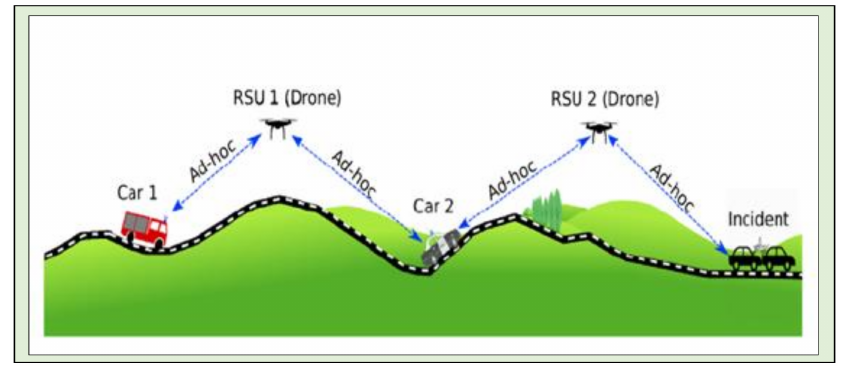
Figure 3. Using UAVs as communication relays [27].